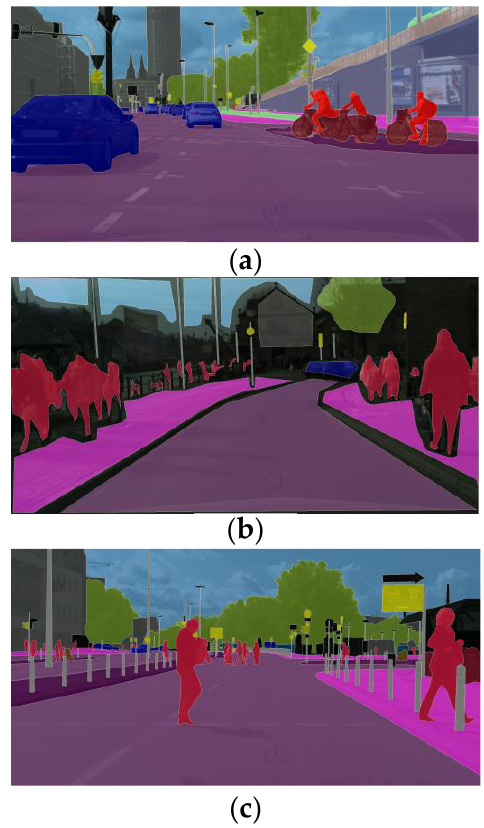
Figure 12. An example of image annotation from the Cityscapes dataset: ( a ) training set/test set — fine annotation; ( b ) training set — rough annotation; ( c ) test set — fine annotation.